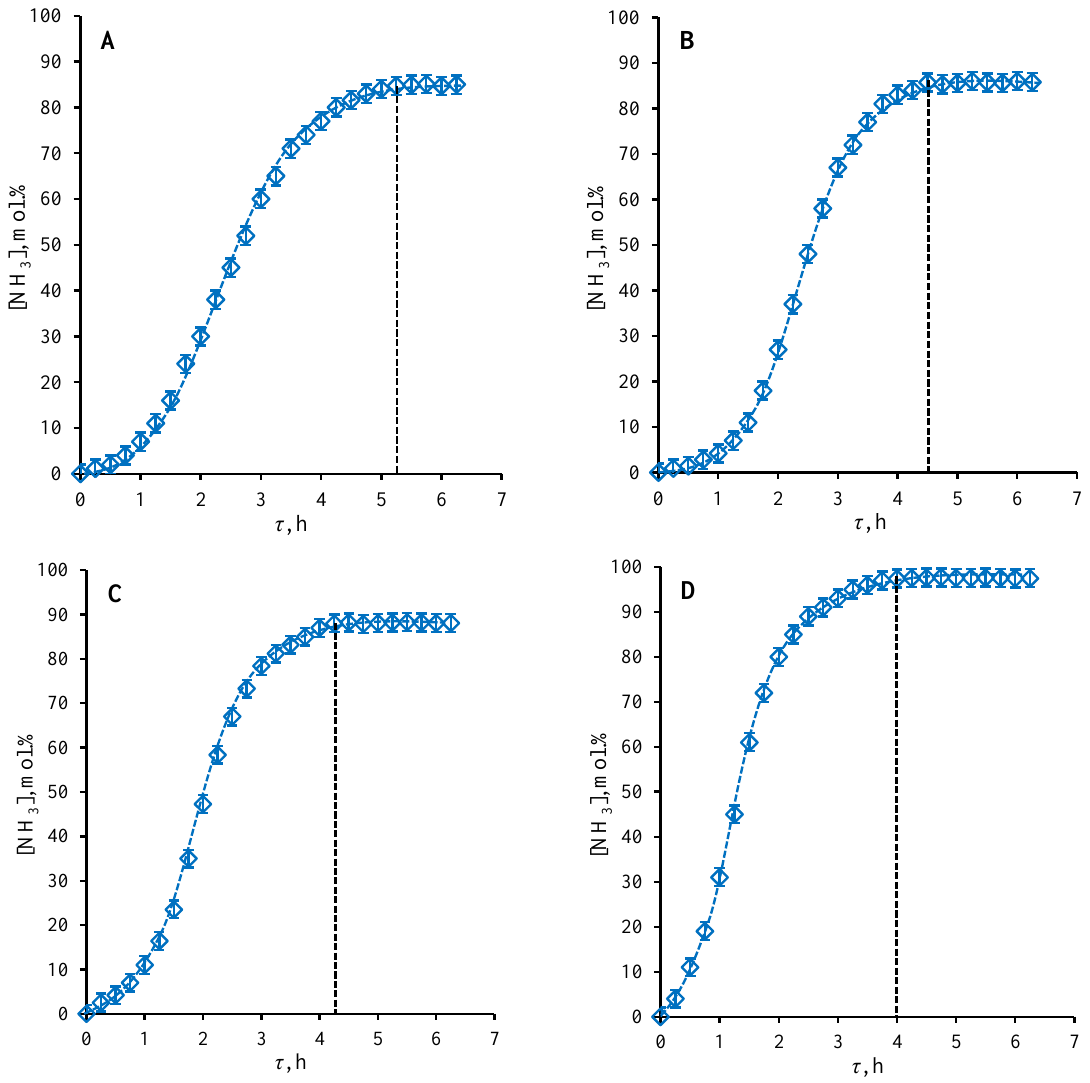
Figure 8. The NH 3 concentration (mol%) in a permeate flow as a function of process operational time (h) during the establishment of the steady-state at 4 different feed flow rates (cm 3 min − 1 ): A — 30.5 cm 3 min − 1 ; B — 34.5 cm 3 min − 1 ; C — 38.5 cm 3 min − 1 ; D — 42.5 cm 3 min − 1 .